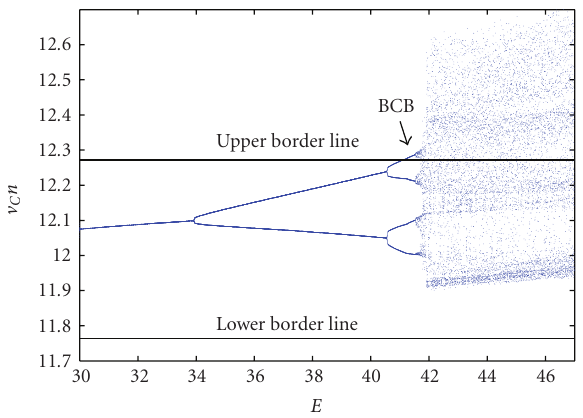
Figure 4: Bifurcation diagram.